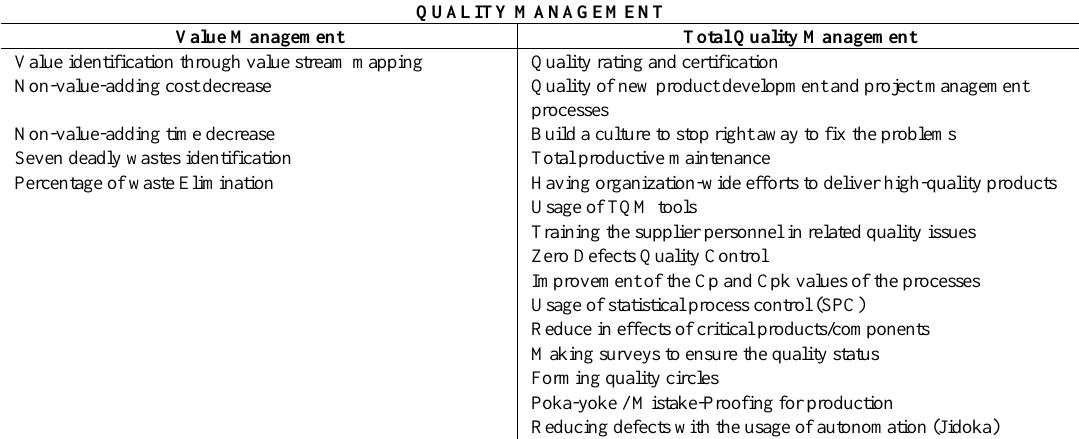
Table 10. Sub-criteria and measures for the quality management main